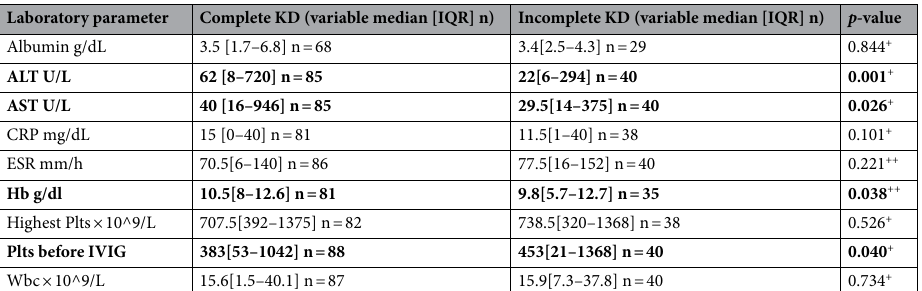
Table 2. Laboratory findings in Complete and Incomplete KD (+ U-Mann–Whitney, ++ Student T-test). Numbers and letters in bold are referring to statistically significant values.